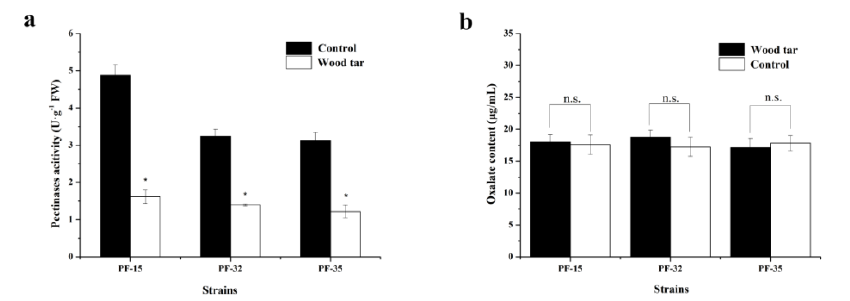
Figure 2. Effect of wood tar on the relative conductivity of the three strains ( a ) PF-15, ( b ) PF-32, and ( c ) PF-35. Bars denote the stand errors of three experiments.